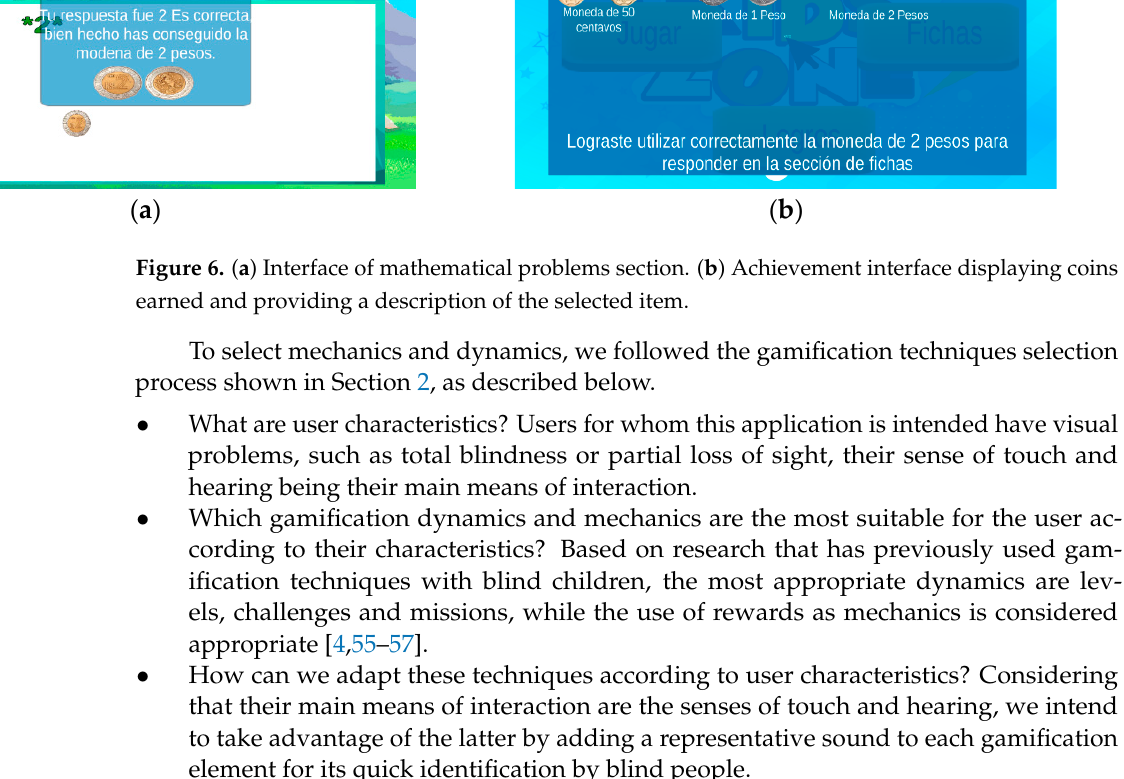
Table 2. Challenges implemented in the game “Learning with Pesos”.